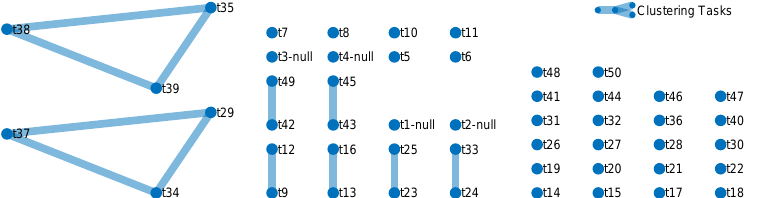
Figure 8. Result of the minimum task clique partition.